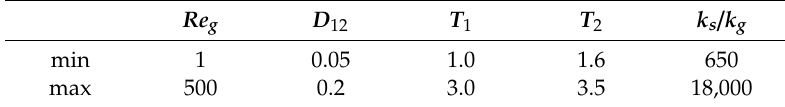
Table 3. Parameter range considered to develop the Eu and Nu-correlations.